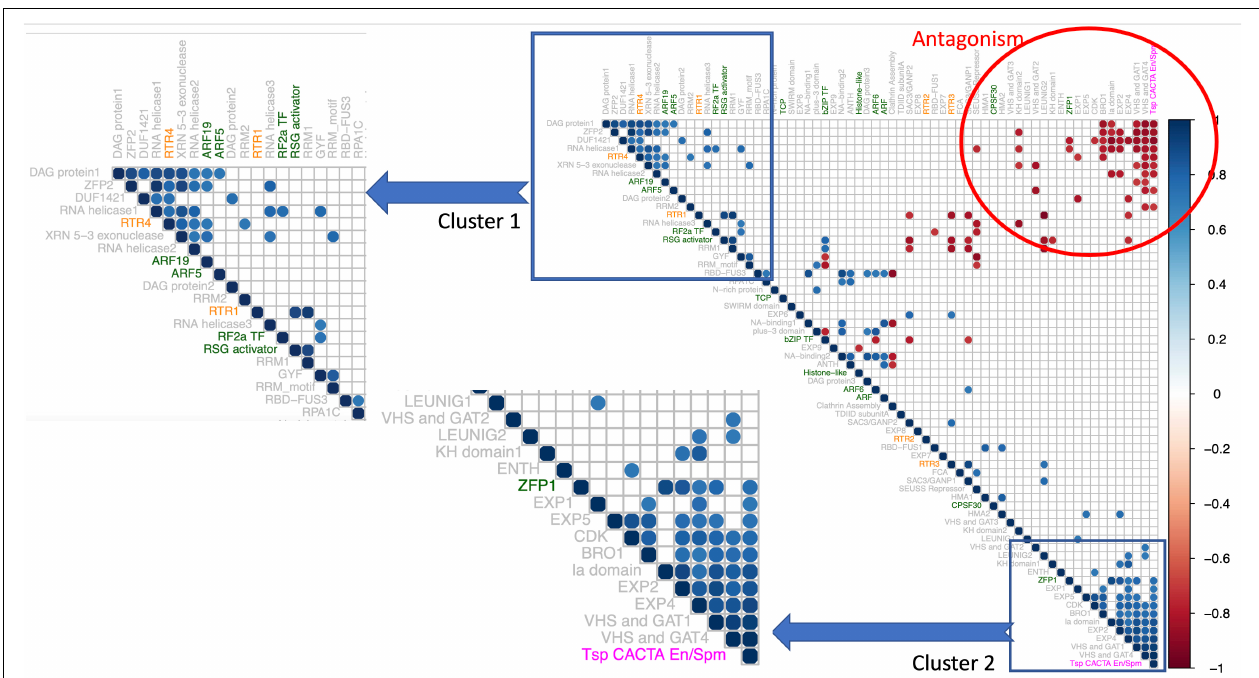
FIGURE 6 | Correlogram of 66 rice PrLPs (listed in Supplementary Table 6 ). Only significant correlations are shown (cutoff + – 0.8 at p < 0.01). Rows/columns ordered by first principal component. The color of PrLP names depicts transcription factors (TFs; green), retrotransposons (RTRs; orange), and Tsp (magenta). Insets show two distinct gene clusters, both with strong intra-cluster synchrony, but both clusters are mutually antagonistic, as can be seen in the upper right corner of the Correlogram (region in red circle).